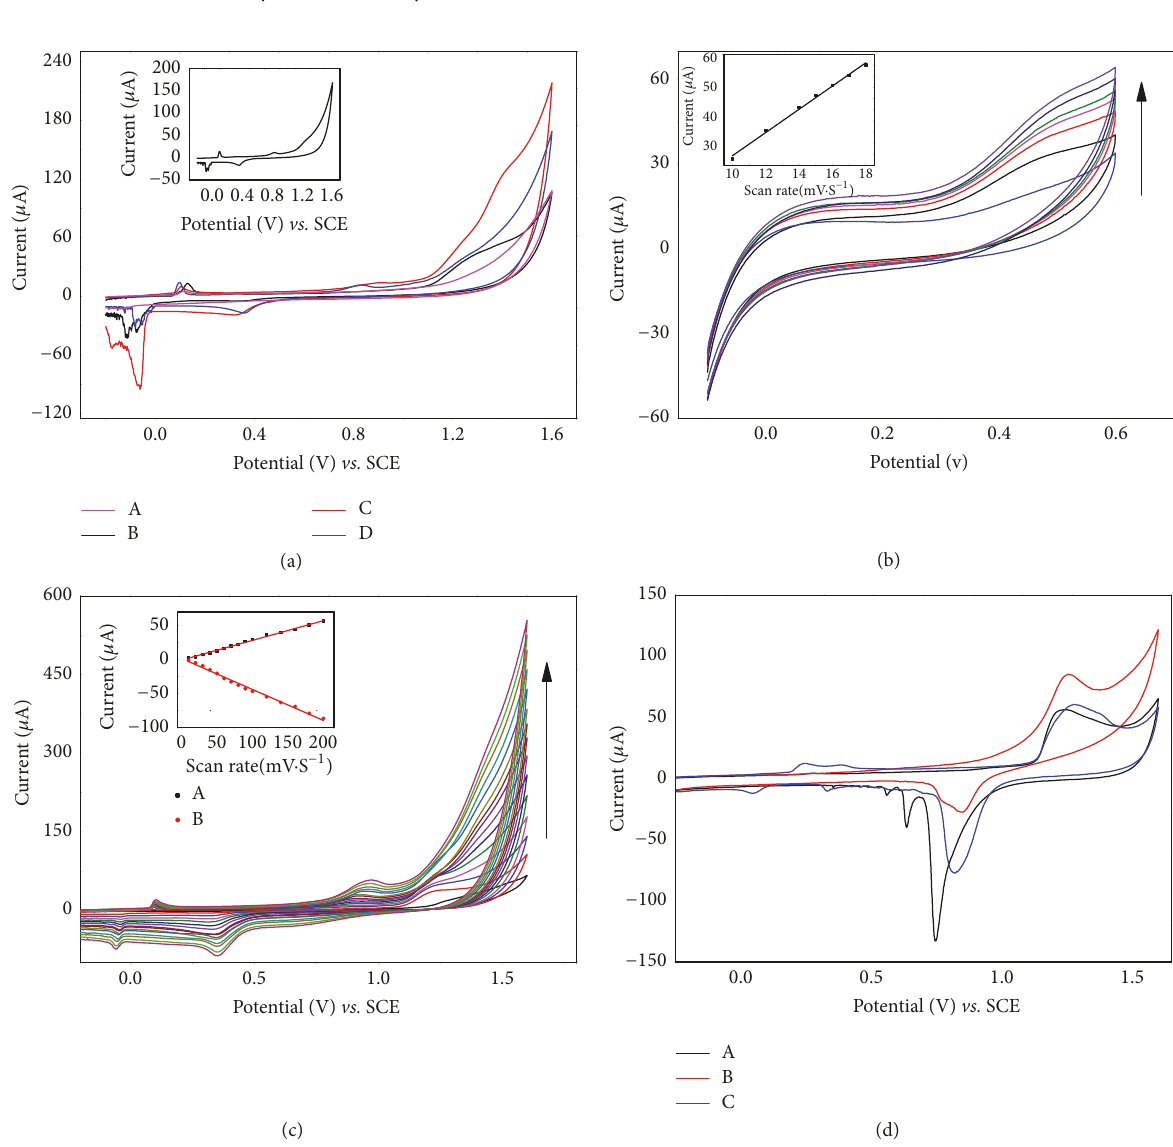
Figure 3: (a) Different modified GCE in 0.1 M PBS (pH = 7.0) under N 2 . Scan rate: 50mVs -1 . (A) Bare GCE, (B) np-AuNPs/GCE, (C) MA- np-AuNPs/GCE, and (D and inset) TEMPO-np-AuNPs/GCE. CVs of np-AuNPs (b) and TEMPO-np-AuNPs ( c) on the GC electrode surface under N 2 , 0.1 M PBS (pH = 7.0) at different scan rates from 10mVs -1 to 200mVs -1 . Inset: ( b ) the linear relationship between the scan rate and the currents at a potential of 0.55V. ( c ) The linear relationship between anodic (black spots, at 0.95 V) and cathodic (red spots, at 0.38 V) peak currents and scan rate. (d) CVs of different electrodes in 0.5 M H 2 SO 4 under N 2 , 0.1 M PBS (pH = 7.0) at a scan rate of 100 mVs -1 .(A) np-AuNPs, (B) MA-np-AuNPs, and (C)